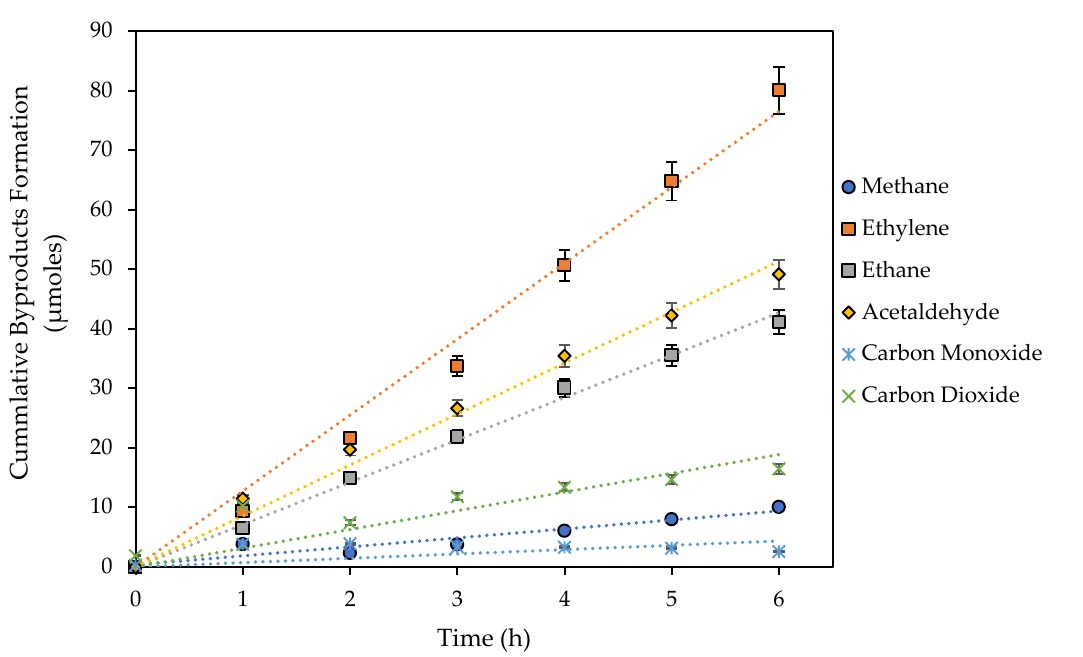
Figure 4. Cumulative amounts of carbon dioxide (CO 2 ), methane (CH 4 ), acetaldehyde (C 2 H 4 O), ethane (C 2 H 6 ), and ethylene (C 2 H 4 ) obtained using a 0.25 wt% Pd-TiO 2 -nUV . Conditions: photocatalyst concentration of 0.15 g/L, 2.0 v/v % ethanol, near-UV light irradiation, and argon atmosphere.